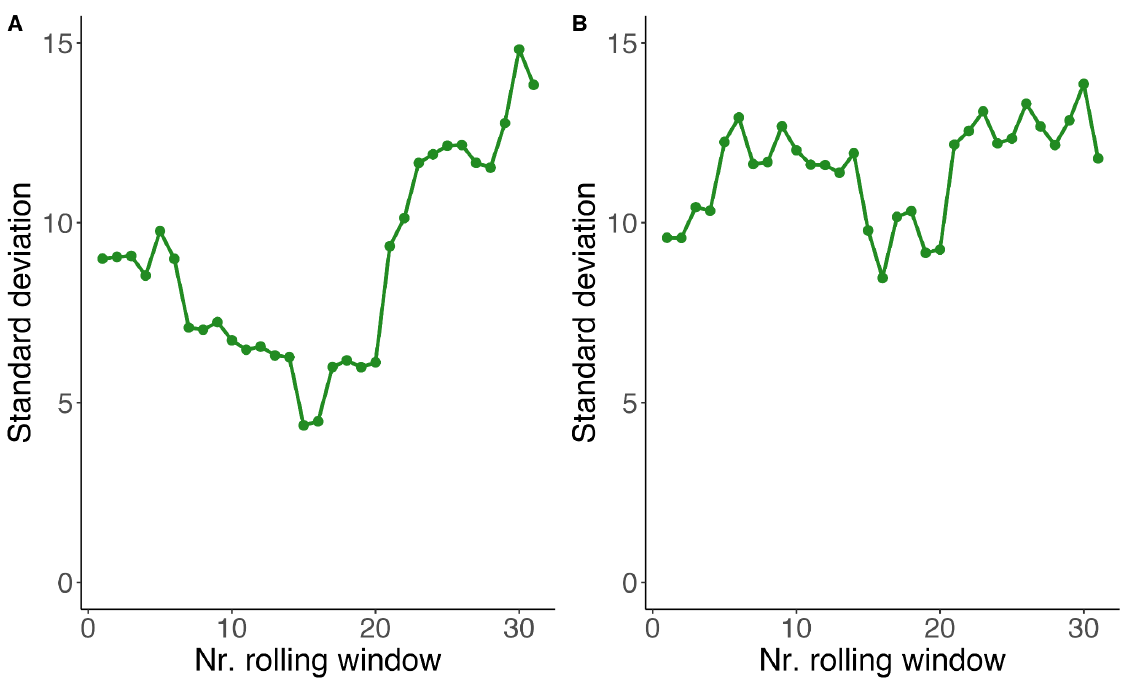
Figure S2. Mean standard deviation of the residuals of the 1000 piecewise regressions on start of the breeding season (A) and 1000 piecewise regression on peak of the breeding season (B) , calculated with a rolling window approach. Window size was 25% of the length of the timeseries (i.e., 10 years out of 40 years, therefore we had 31 windows).